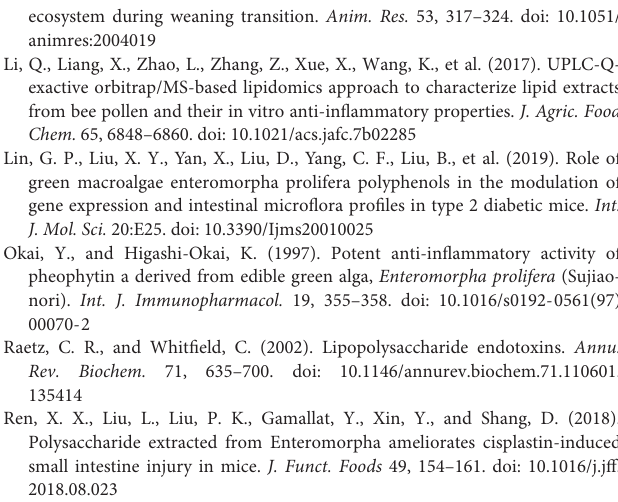
FIGURE S1 | Complete protein band of I κ B α and pI κ B α . FIGURE S2 | Complete protein band of pNF κ B. FIGURE S3 | Complete protein band of β -actin. FIGURE S4 | Complete protein band of NF κ B. TABLE S1 | Primer sequences for RT-PCR. TABLE S2 | Characterization of components of Blidingia sp. extract by UHPLC-Q-Extractive-Orbitrap/MS